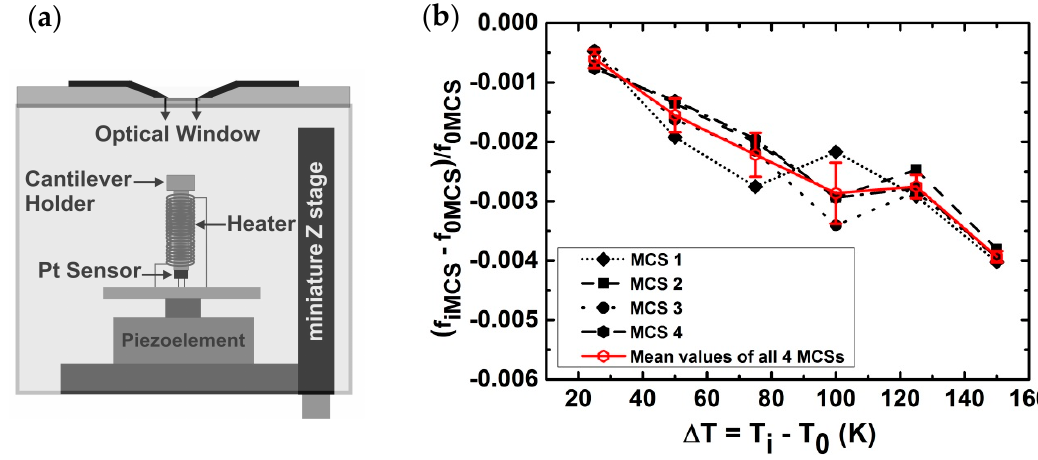
Figure 4. ( a ) The schematic shows the experimental chamber used for the uniform heating of the MCSs in quasi-sealed condition. The schematic is not to scale; ( b ) For each MCS (in black) and their corresponding mean values (in gray) the measured values of ∂ f is plotted versus ∆ T = T − T 0 . Here, f 0 MCS is the initial resonance frequency measured at T 0 = 298 K and f iMCS is the resonance frequency measured at desired temperatures of T i during the uniform heating from T 0 = 298 K to T = 450 K. A fit on the mean values graph of all four cantilevers yields the mean slope of − 25.75 ± 1.94 × 10 − 6 K − 1 with the intersection value of − 0.0039 × 10 − 6 with the vertical axis. All resonance frequency values are evaluated from the circle fit method with the precision of 0.1